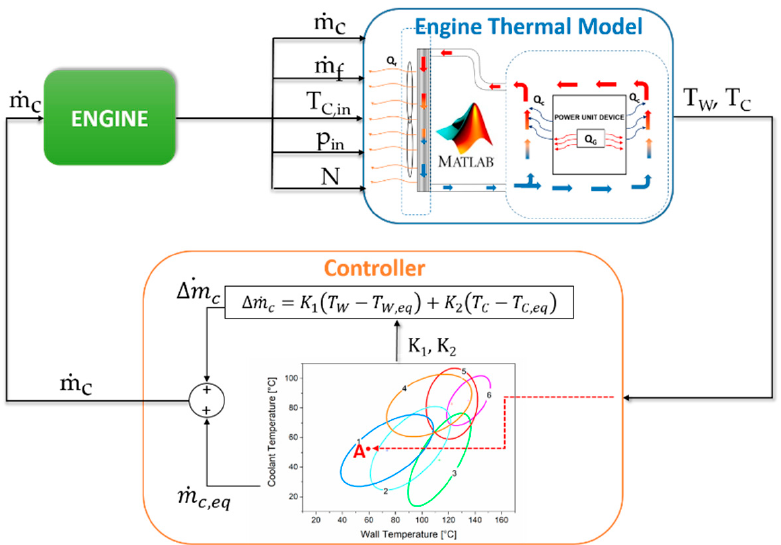
Figure 3. Schematic of the interaction between the model and the controller. The variables computed by the model determine the state of the system and define the control stability region.